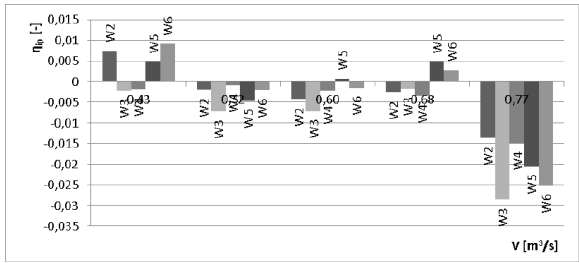
Fig. 4. Relative change in internal efficiency